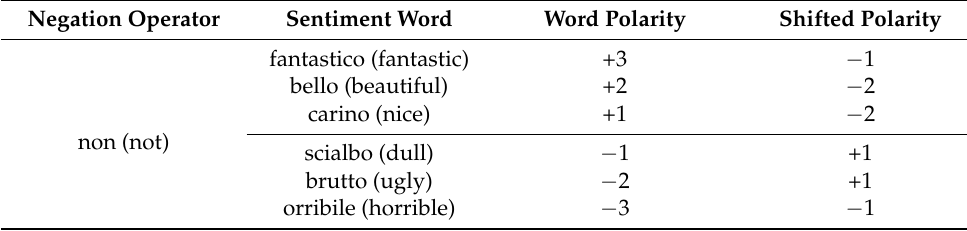
Table 2. Negation rules.